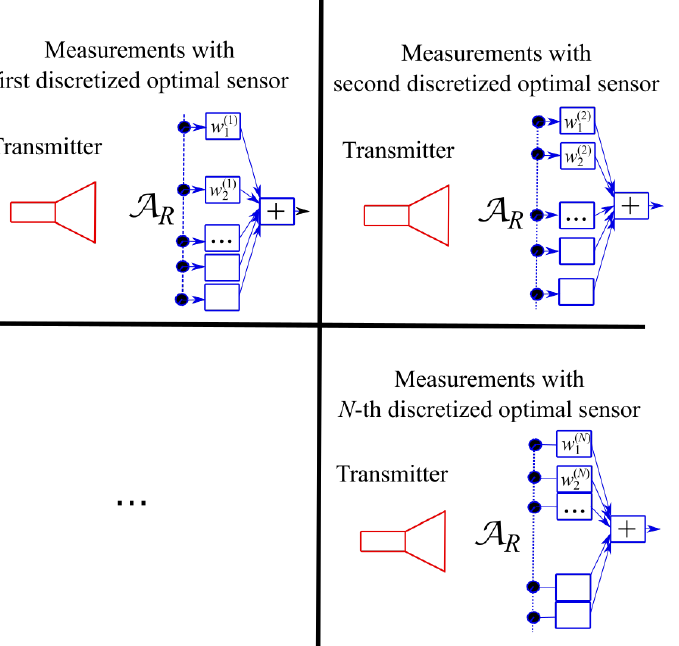
Figure 5. If the element positions must keep the same across the different “optimal virtual” sensors because we want to deal with a unique set of array elements, then we must enforce a constraint.